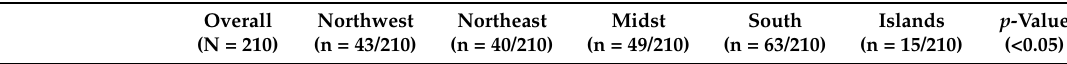
Table 5. Competence area in wound care: care of chronic and acute wounds. Each query expects a score value as an answer, based on a seven-point scale (Likert scale) ranging from 1 (strongly disagree) to 7 (strongly agree). Results are shown as mean ± standard deviation (mean ±